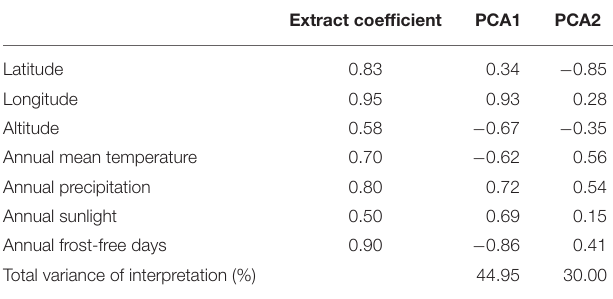
TABLE 5 | Results of PCA analysis of environmental factors of C. paliurus